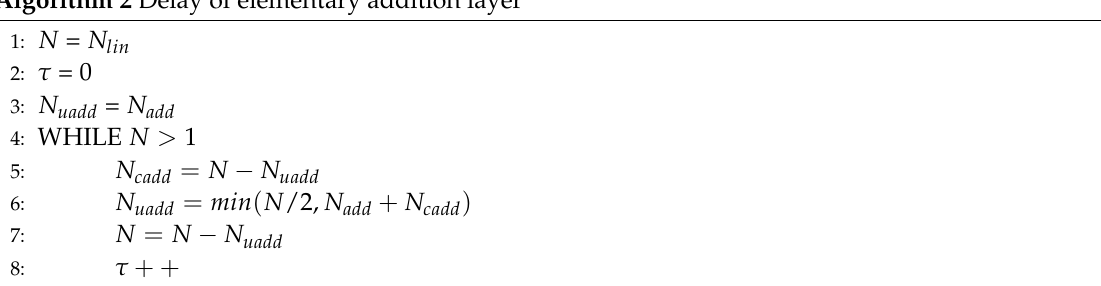
Algorithm 2 Delay of elementary addition